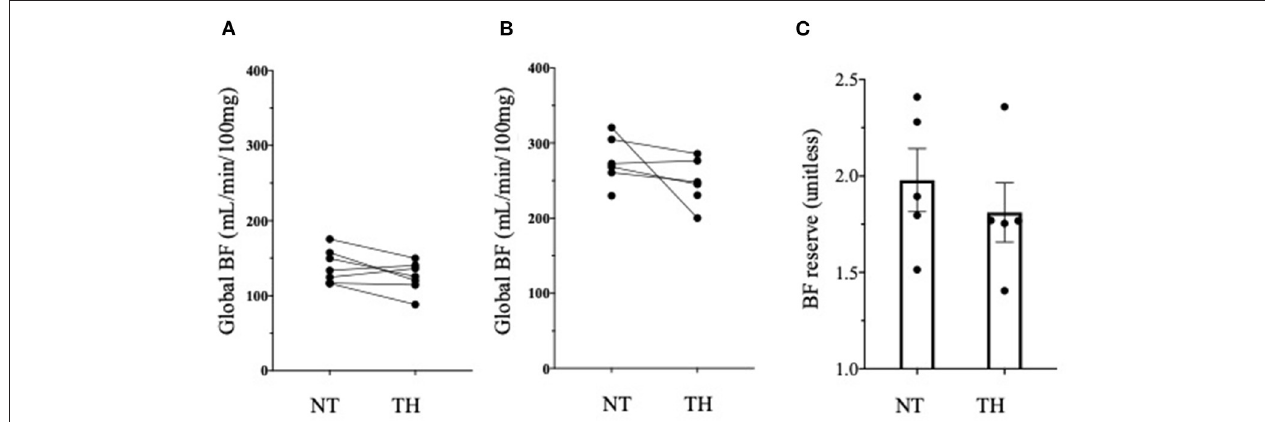
FIGURE 3 | Myocardial blood flow (BF) and myocardial reserve. (A) We found no difference in Myocardial BF expressed in mL/min/100g between normothermic (NT) and therapeutic hypothermia (TH) at rest using Wilcoxon test. (B) We found no difference in Myocardial BF expressed in mL/min/100g between normothermic (NT) and therapeutic hypothermia (TH) at stress using Wilcoxon test. (C) We found no difference in myocardial reserve between NT and TH conditions.